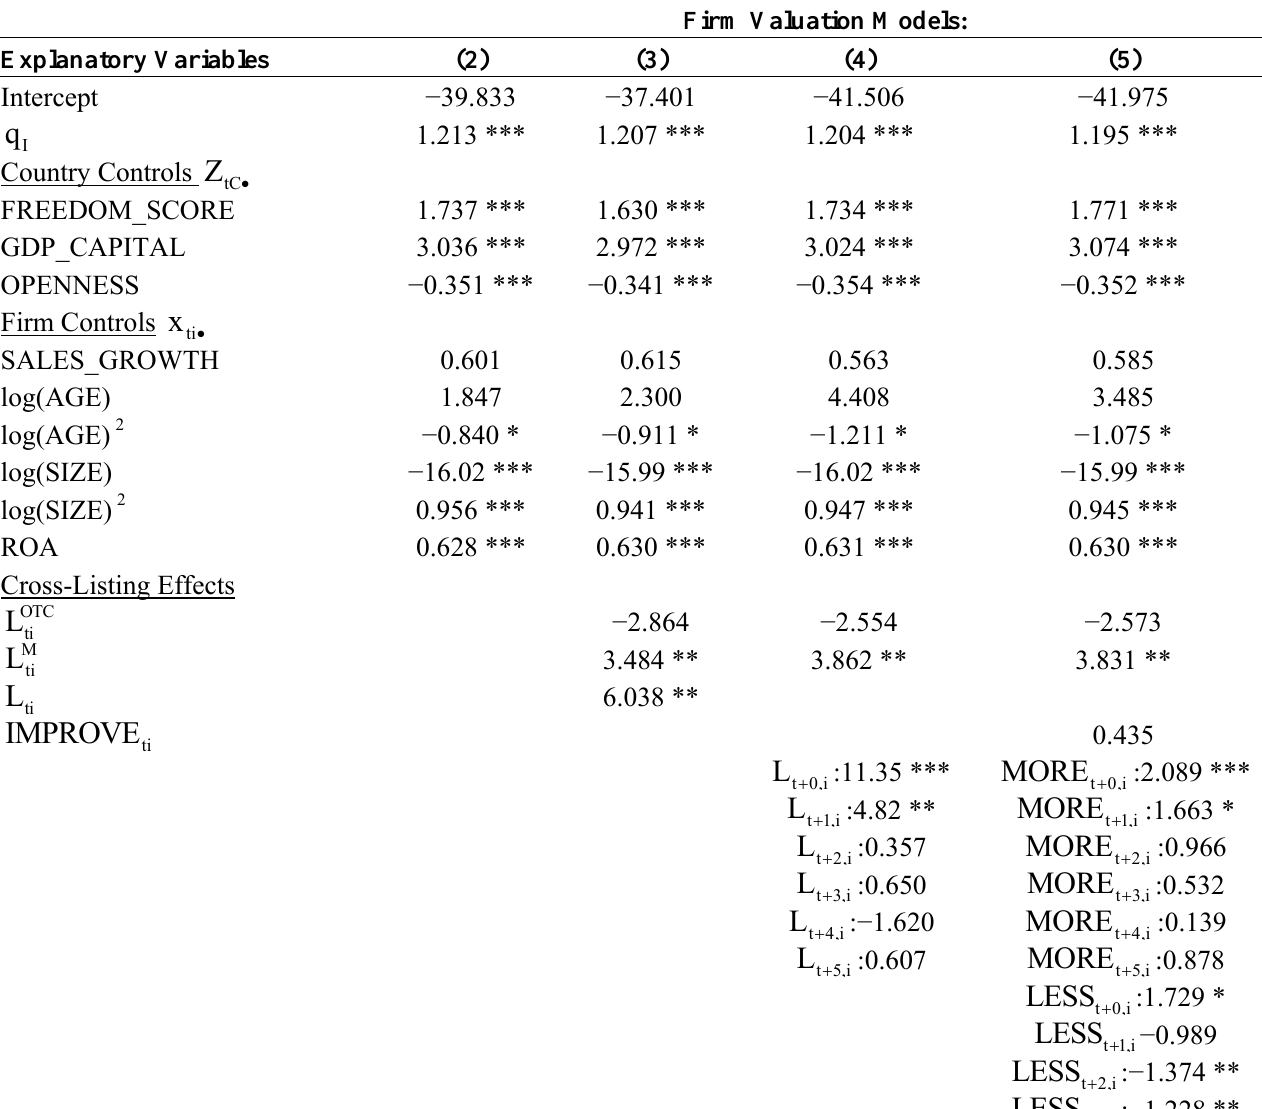
Table 7. Conditional Regressions on Firms that Cross Listed, Excluding U.S. Official Cross Listings Dependent Variable: Firm’s Tobin’s